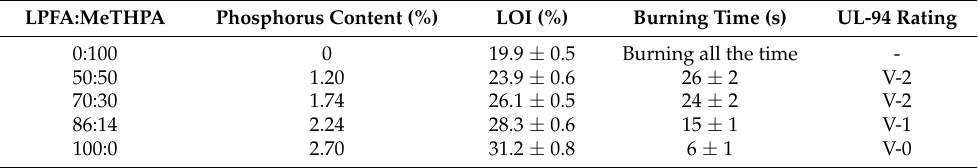
Table 1. LOI measurement and UL-94 test of cured bisphenol-A epoxy resin